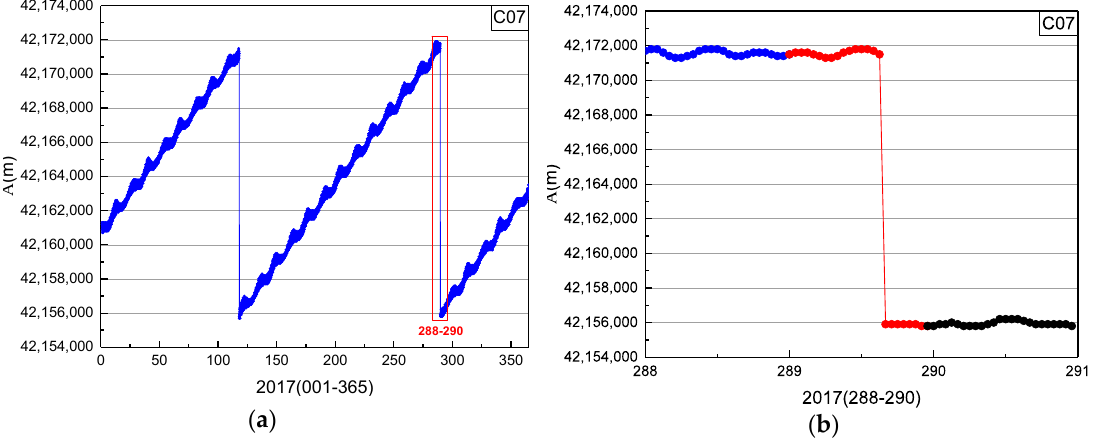
Figure 12. Time series of orbital semimajor axis of C07 in 2017: ( b ) detailed information of the red box (days 288–290) in ( a ).